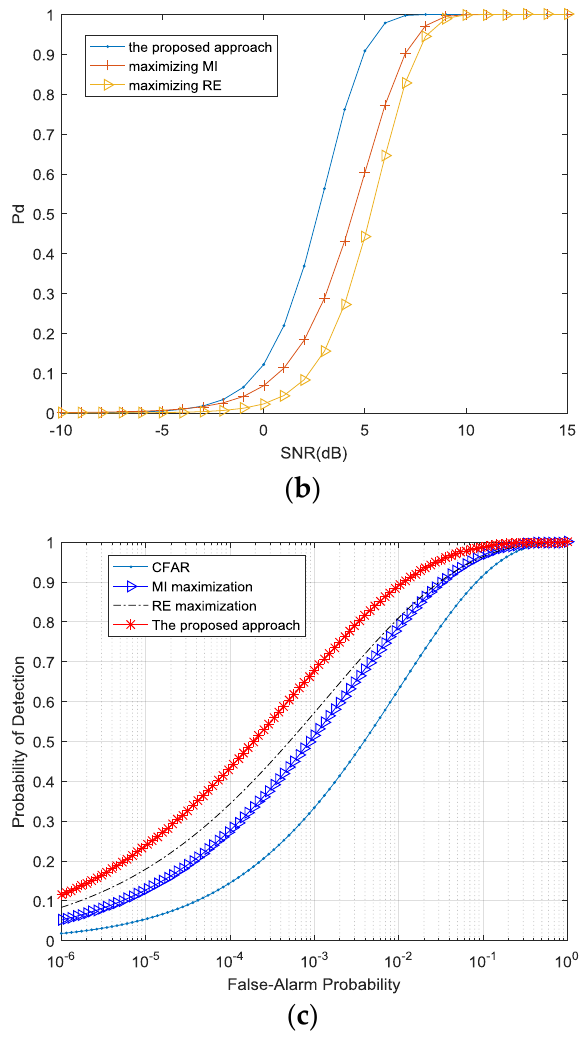
Figure 4. ( a ) Detection probability for various iterations of the proposed approach; ( b ) Detection probability for three approaches; ( c ) The ROC for four configurations.